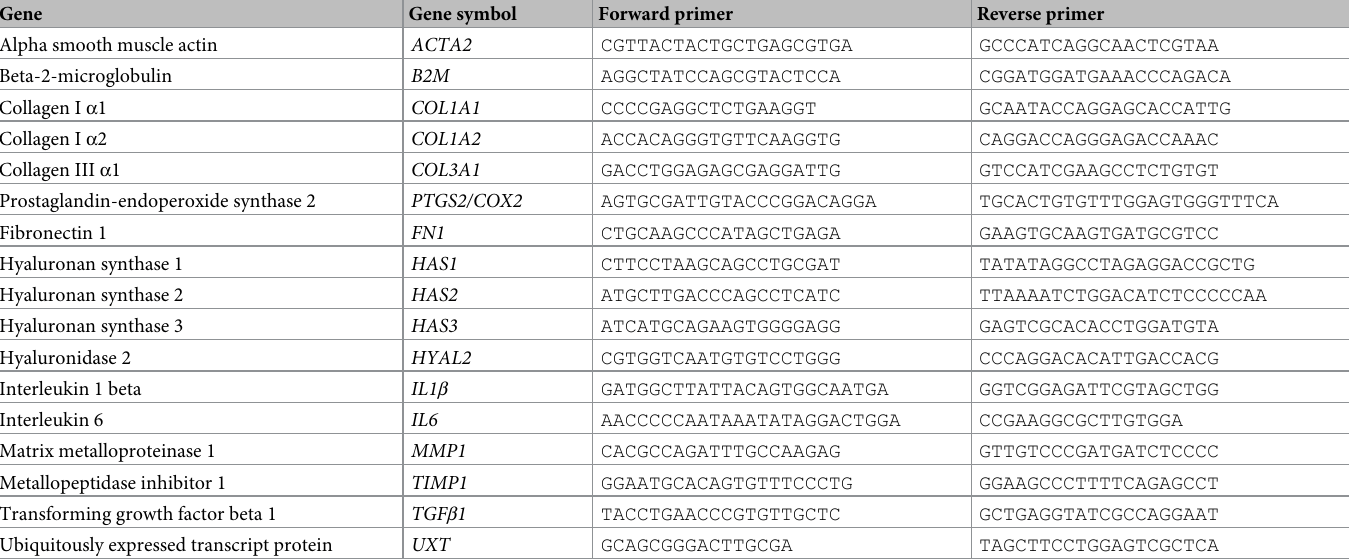
Table 1. Primer sequences used for